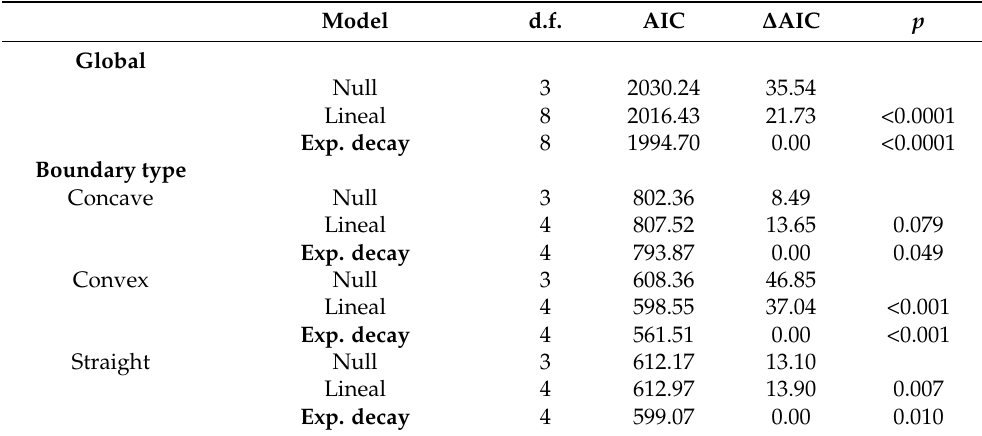
Table 2. Results of Linear Mixed Models (LMM) describing how woody density in mines varied with increasing distance to the forest edge. The best models (lowest AICs) are highlighted in bold. p indicates the significant differences between the null and the alternative models after the